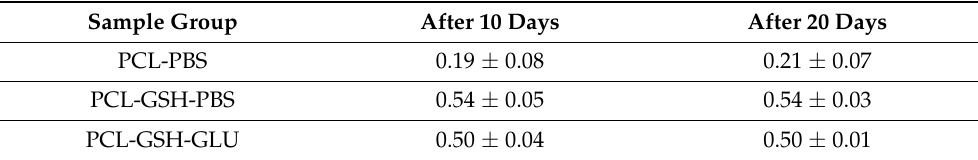
Table 1. Percentage of weight change of different sample groups after 10 and 20 days in soaking PBS (n = 5).